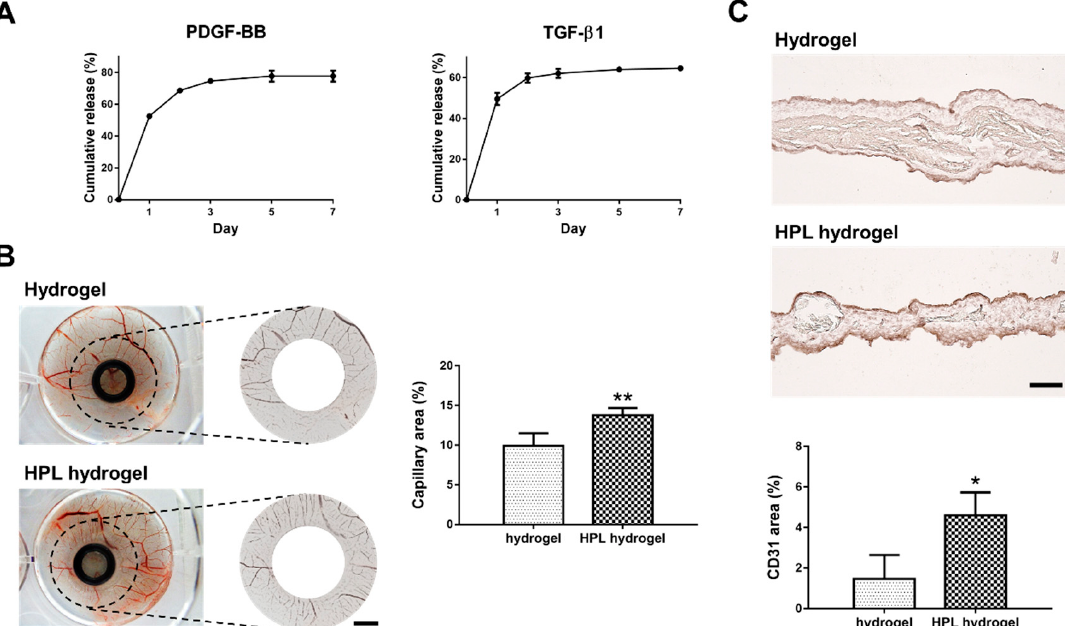
Figure 7. The release of growth factors from CS-GE hydrogels and chick chorioallantoic membrane (CAM) assay. ( A ) The cumulative releases of PDGF-BB and TGF- β 1 from HPL-incorporated hydrogel. ( B ) The representative photographs of CAMs after treatment with CS-GE hydrogel only or HPL-incorporated CS-GE hydrogel, which were loaded on the CAMs of day 7 chick embryos. After 72 h of incubation, CAMs were excised and photographed (scale bar = 3 mm). Blood vessel formation on the CAM was quantified by measuring the capillary area percentage around the implanted hydrogels. ( C ) Immunohistochemistry staining of the endothelial marker CD31 in the CAM sections (scale bar = 100 µ m). The ratio of the CD31-positive area was significantly larger in the group with HPL-incorporated CS-GE hydrogel. (* p < 0.05, ** p < 0.01).